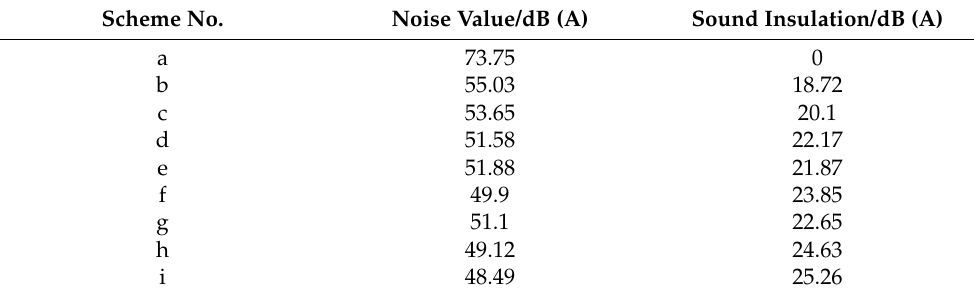
Table 2. Experimental results of the sound insulation structure scheme. Scheme